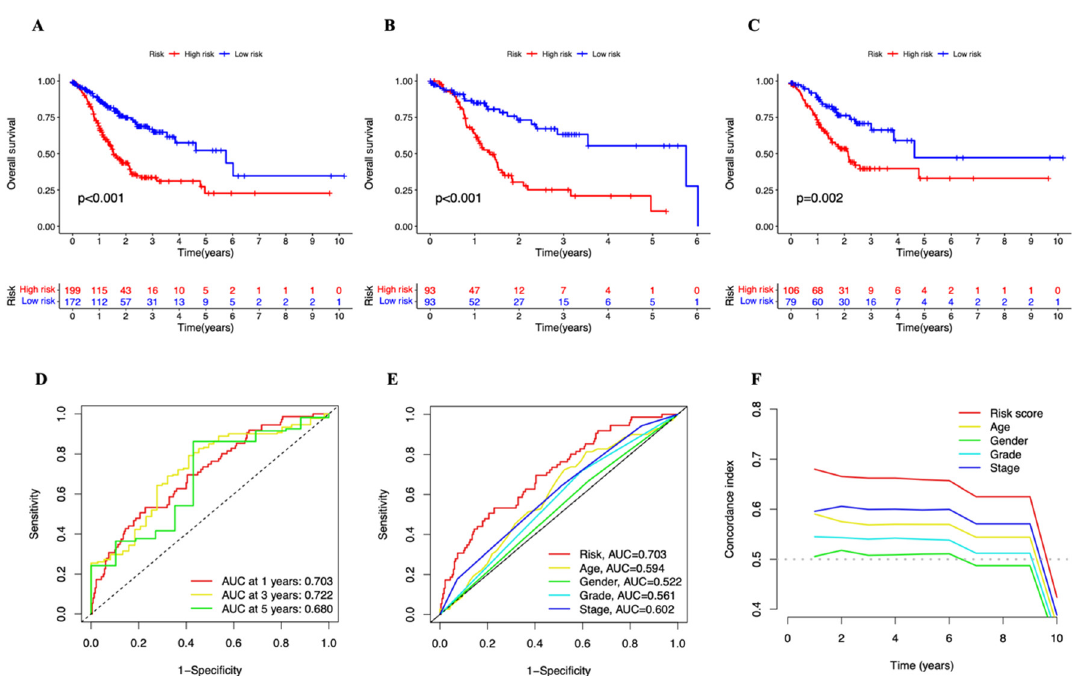
Figure 3. Validation of cuproptosis-associated lncRNA signature in STAD ( A – C ) Kaplan–Meier survival curves of overall survival of STAD patients in low- and high-risk groups in the entire, train, and test sets, respectively. ( D ) ROC curve of the cuproptosis-associated lncRNA signature in the entire set. ROC curve, receiver operating characteristics curve; AUC, area under the curve; p < 0.05, statistically significant. ( E ) ROC demonstrated the predictive accuracy of the risk model was superior to other clinical parameters. ( F ) The C-index curve showed the predictive accuracy of the risk model was superior to other clinical parameters. C-index curve, concordance-index curve.